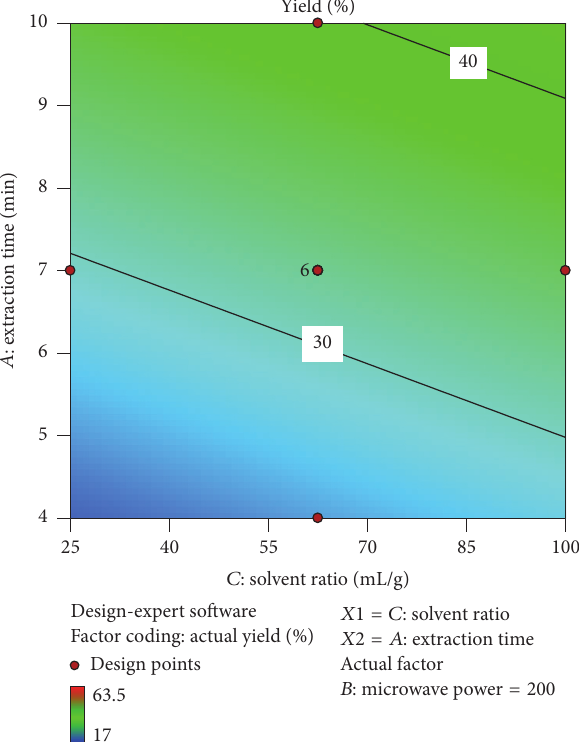
Figure 2: Response surface plot of the interaction between time ( 𝐴 ) and power ( 𝐵 ) on the extraction yield of roselle seed.